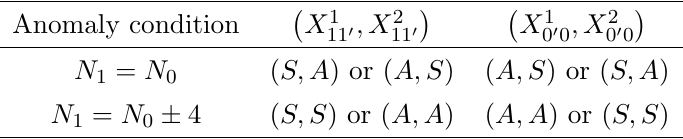
Table 11. The various unoriented projections b (cid:10) of C 3 = Z 4 with gauge groups U( N 0 ) (cid:2) U( N 1 ). \A" stands for \Antisymmetric representation", while \S" for \Symmetric